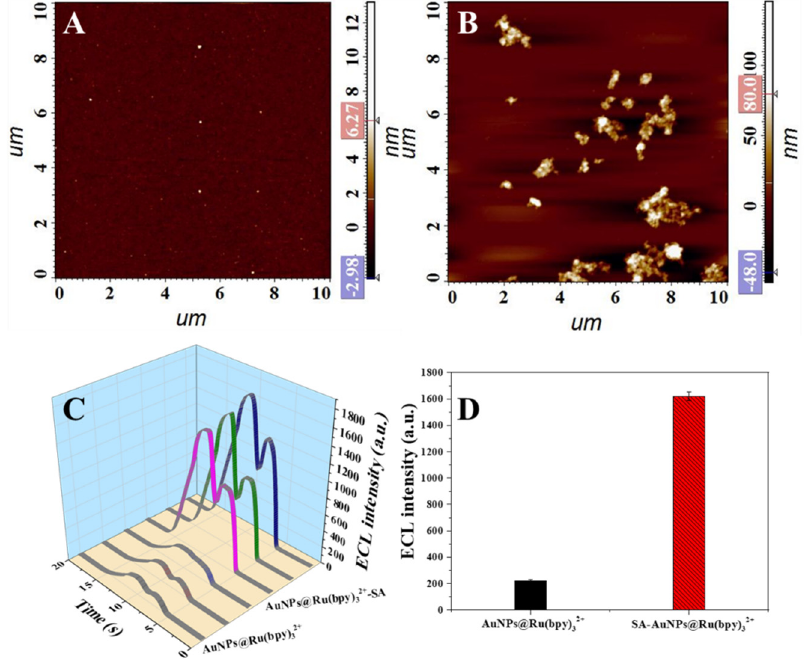
Figure 6. AuNPs@Ru(bpy) 32+ -SA attached to BSA ( A ) and biotinylated BSA ( B ) blocked silica wafers; ECL real-time response comparison ( C ) and measured values comparison ( D ) of AuNPs@Ru(bpy) 32+ and AuNPs@Ru(bpy) 32+ -SA mixed with biotinylated magnetic microspheres.